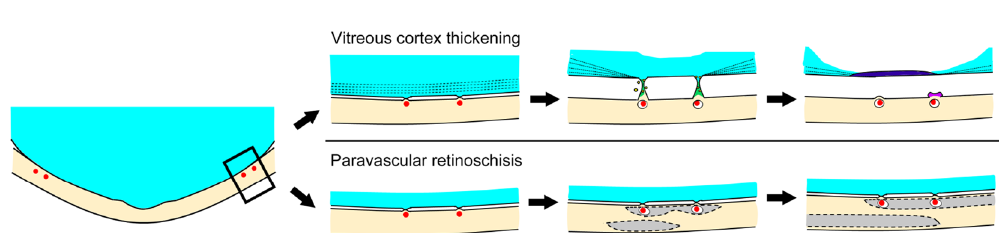
Figure 7. Schematic illustration showing the course of development of the vitreous cortex thickening and paravascular retinoschisis (RS). In the paravascular area, lamellar structural posterior vitreous cortex attaches to the inner retinal surface. As the posterior vitreous detachment progresses due to an irregular vitreoretinal adhesion, perivascular retinal tissue and posterior vitreous cortex pull each other. Then the perivascular retinal cells (yellow) migrate on the vitreous cortex layer and form bridging tissues (green). Finally, the dislocated perivascular cells form a lamellar vitreal cortex layers and merge into a single thick vitreous membrane (dark blue) and deteriorated perivascular tissues occasionally remain as debris on the retinal surface (purple). On the other hand, broad paravascular vitreal adhesions induce paravascular RS initially (grey). Finally, we suggest that the paravascular RS extends to the macular area and eventually develops a macular